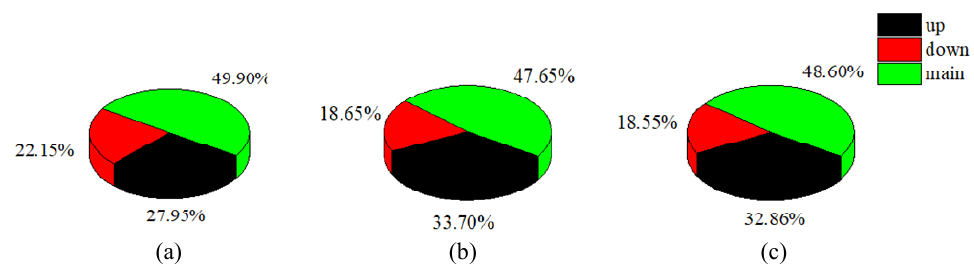
Figure 14. Comparison of proportion distribution of each region. ( a ) ORI; ( b ) SES; ( c ) CCT. Table 2. Relative variation in loss.